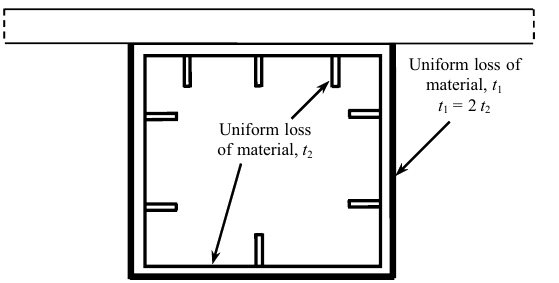
Uniform loss of material, t 1 t 1 = 2 t 2